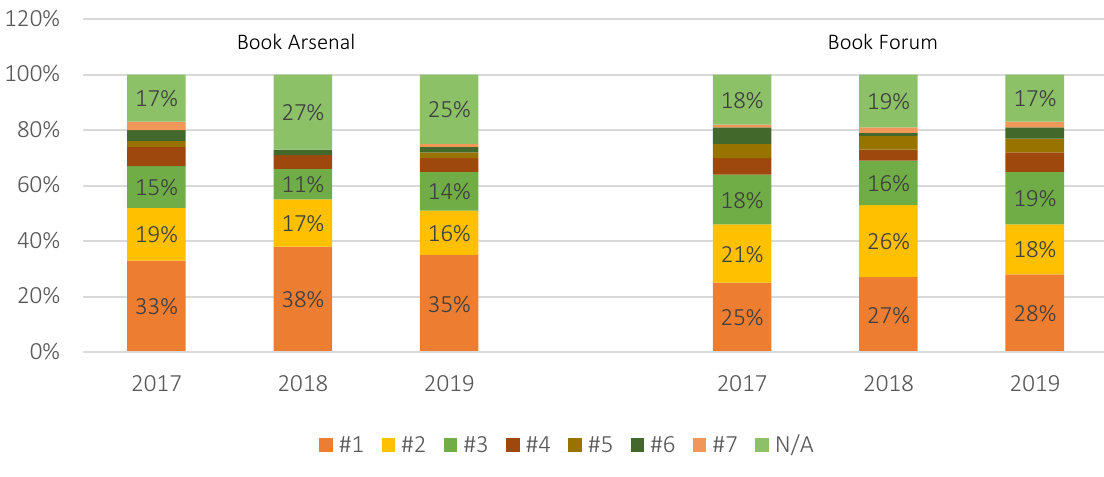
Figure 3. Results of a survey of visitors to book activities about their friends as a source of information about book novelties and publishing